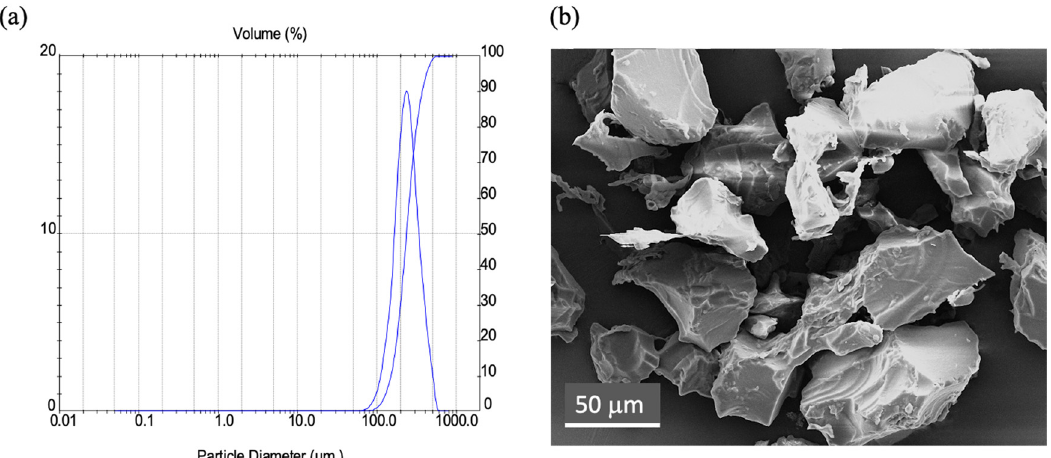
Figure 3: Microcarriers oxi - HA/ADH hydrogel as microcarriers prepared at 18,000 rpm and pH 7: ( a ) cumulative hydrodynamic diameter and volume distribution and ( b ) surface scanning electron microscopic image.